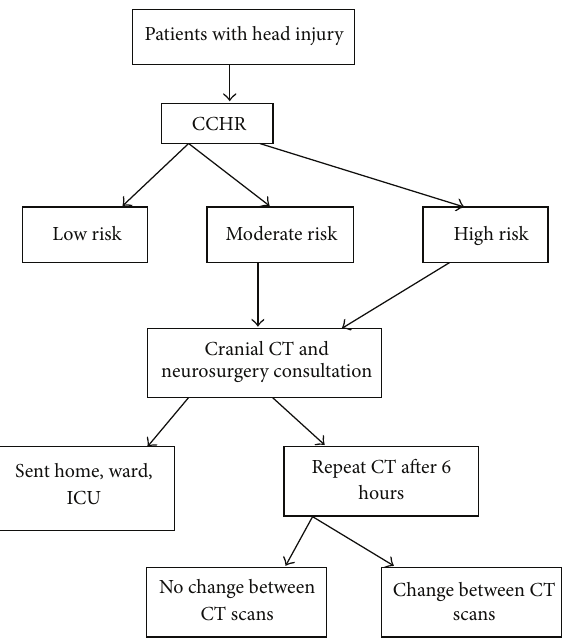
Figure 1: Study flow diagram (CCHR: Canadian CT Head Rule, CT: cranial tomography, and ICU: intensive care